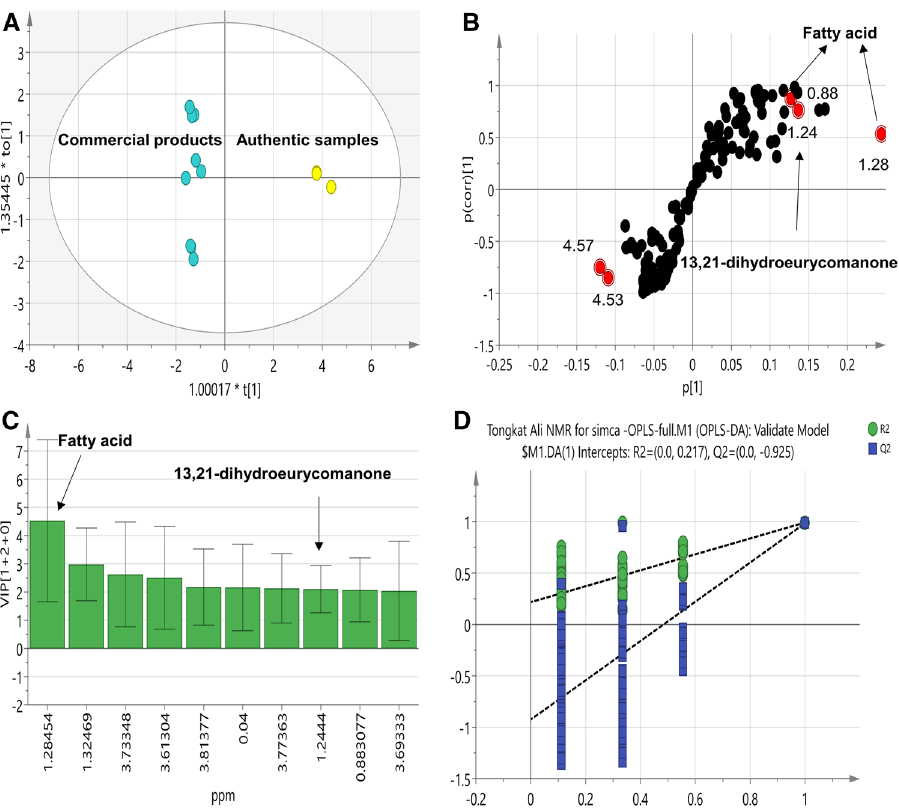
Figure 3. (A) OPLS-DA score plot and ( B) loading S-plots derived from E. longifolia authentic root modelled against other commercial samples analysed by 1 H-NMR, n = 3 . The p(corr)[1] axis represents the correlation of the bin towards the predictive variation. The p[1] axis represents the magnitude of the spectral bins. ( C) Top 10 variables that have the greatest influence on the projection as revealed from the developed OPLS-DA. ( D) Permutation test (n = 200) as a validation criterion for the OPLS-DA model, the test verifies the validity of the model with negative intercept for the Q2